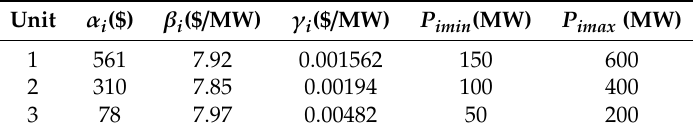
Table 1. Generator unit capacity and coe ffi cients on the first case study.